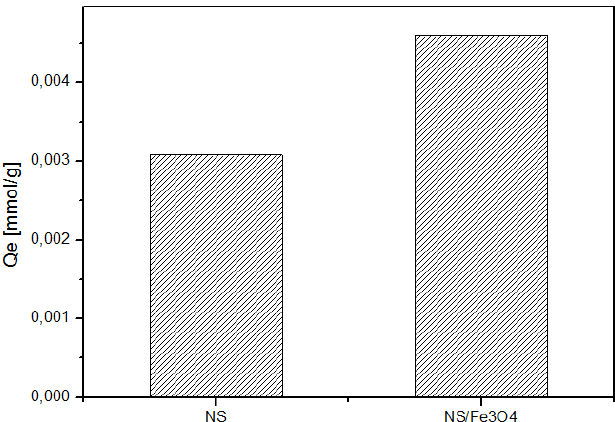
Figure 11. Amount of DTF adsorbed with plain NSs and magnetic NSs.